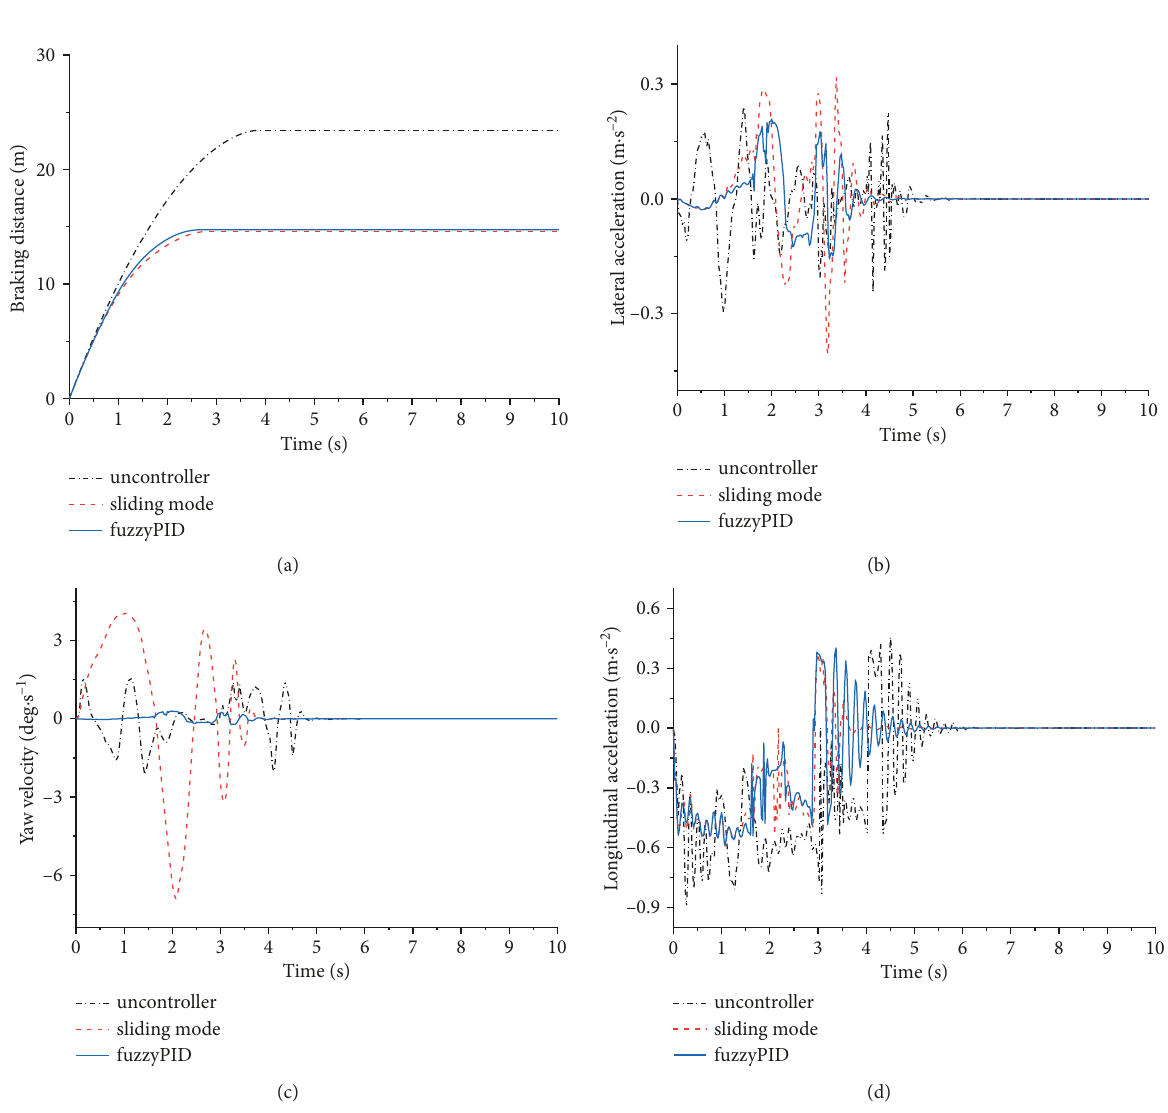
Figure 21: Simulation diagram of curve driving with long downhill braking efficiency of 50% at u � 0.75. (a) Braking distance. (b) Lateral acceleration. (c) Yaw velocity. (d) Longitudinal